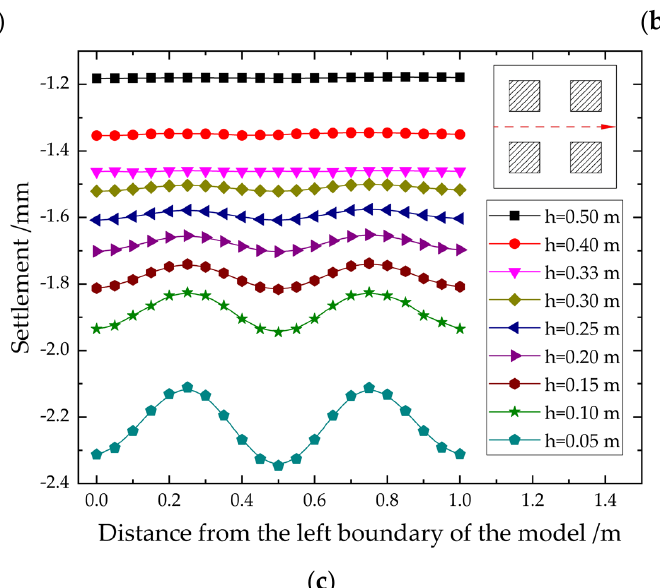
Figure 15. The curve of Vertical displacement in embankment, ( a ) result of M1; ( b ) result of M3; ( c ) Figure 11. Verification of the finite element result of M4.